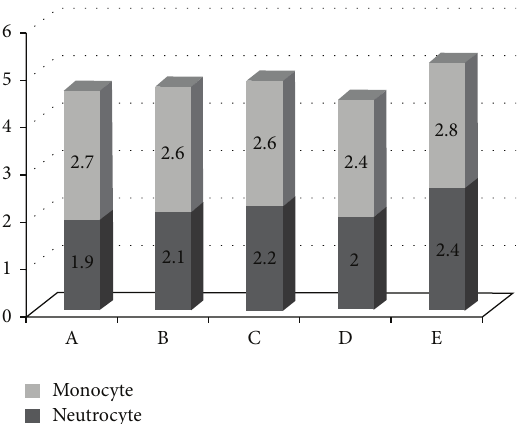
Figure 3: The severities of inflammatory cell infiltration were shown. There was no obvious difference of neutrocyte infiltration among these groups. Similar result was also noted in severities of monocyte infiltration.